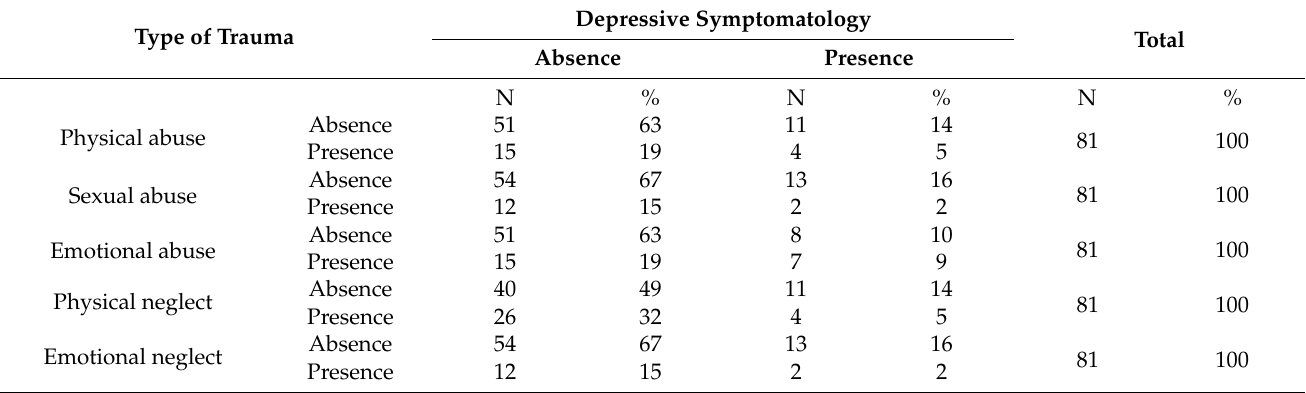
Table 3. Frequency of comorbidity between childhood trauma and depressive symptomatology.